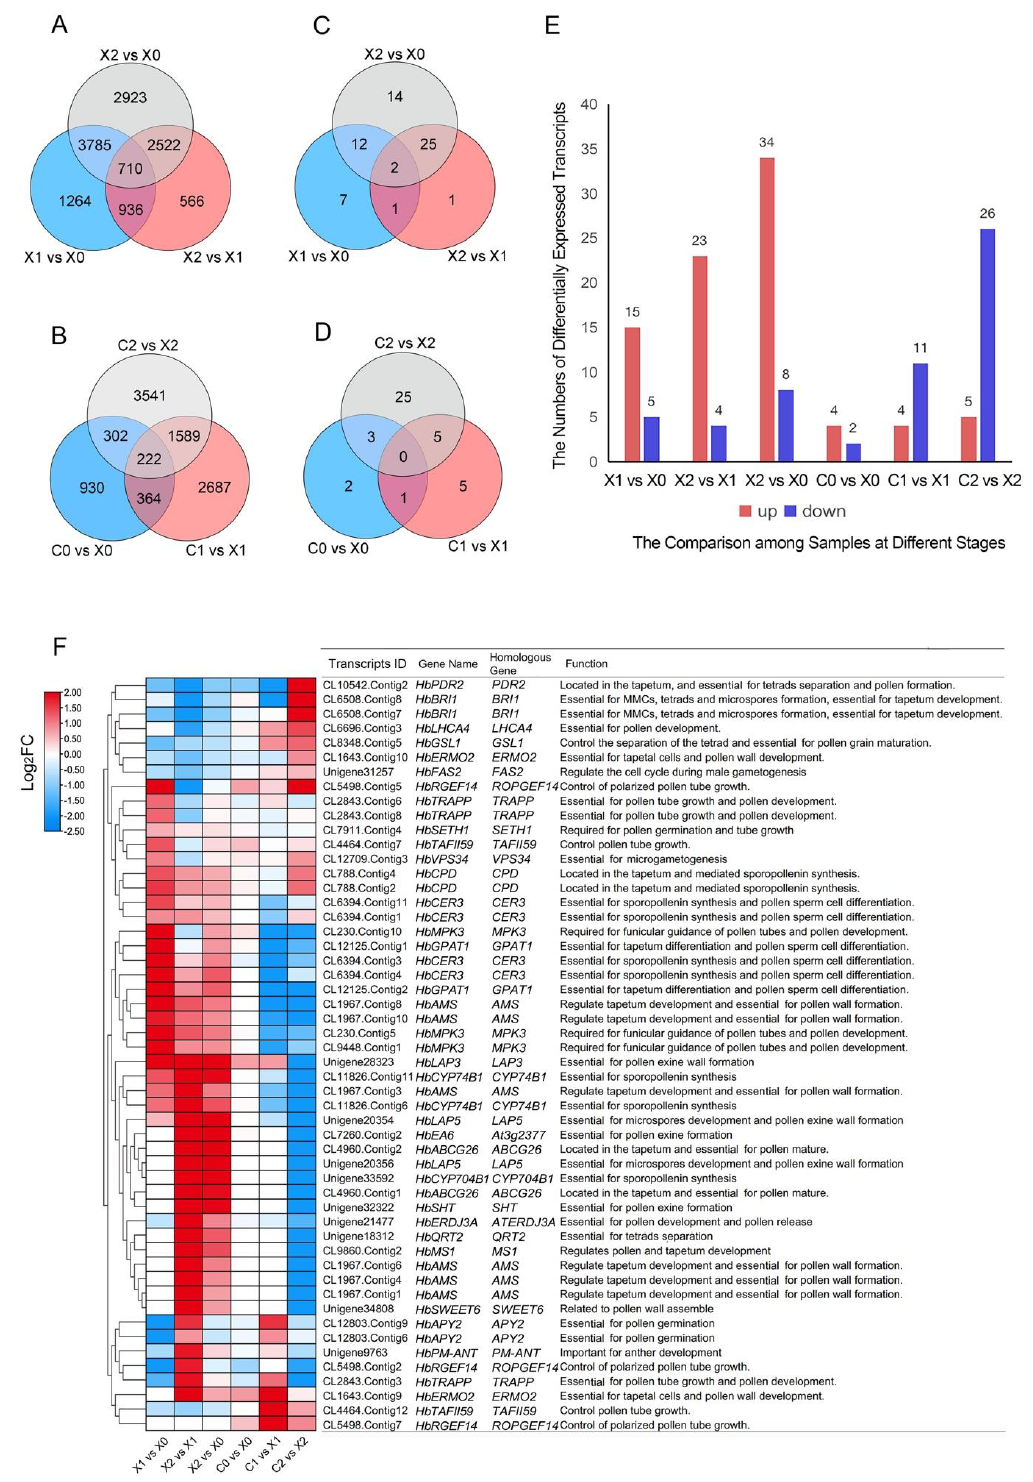
Figure 3. Analysis of the differentially expressed transcripts in male and female floral buds. ( A , C ) Numbers of the differentially expressed transcripts in male flowers; all transcriptome and anther development–related genes. ( B , D ) Numbers of the differentially expressed transcripts in female flowers; all transcriptome and anther-related genes compared with male flowers ( E ) Numbers of the up-regulated and down-regulated differentially expressed transcripts in male and female flowers’ anther-related genes. ( F ) log2-transformed fold change (log2FC) values are depicted by color range from blue (down-regulated) to red (up-regulated). Slashes represent a pairwise comparison between two samples. Bar plots show the